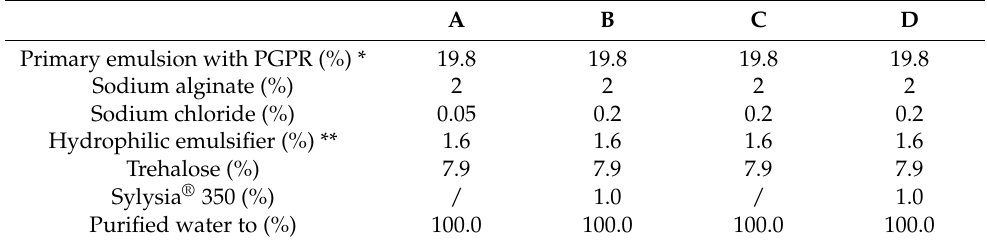
Table 2. A–D: Double (W/O/W) emulsion